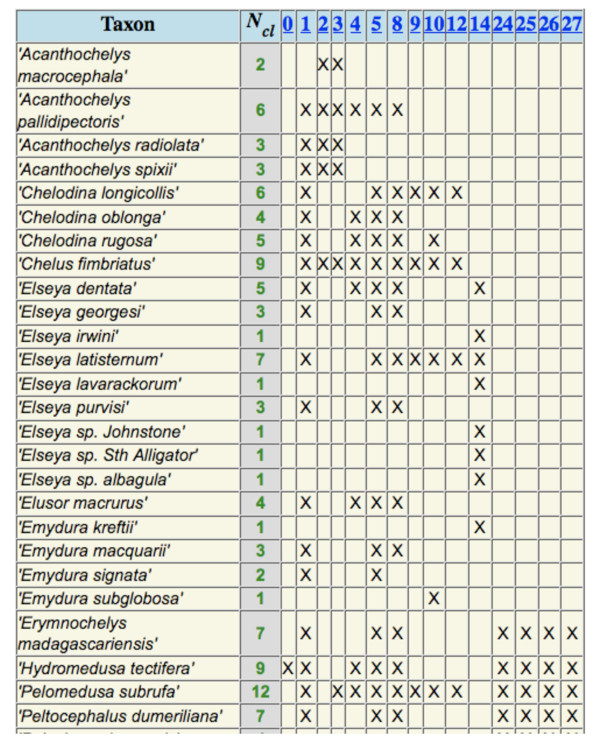
An empirical taxon coverage pattern. This example was extracted from the PhyLoTA database (therein called the "data availability matrix"), for sequenced loci for the vertebrate clade Pleurodira (side-necked turtles). Only some of the taxa are shown.